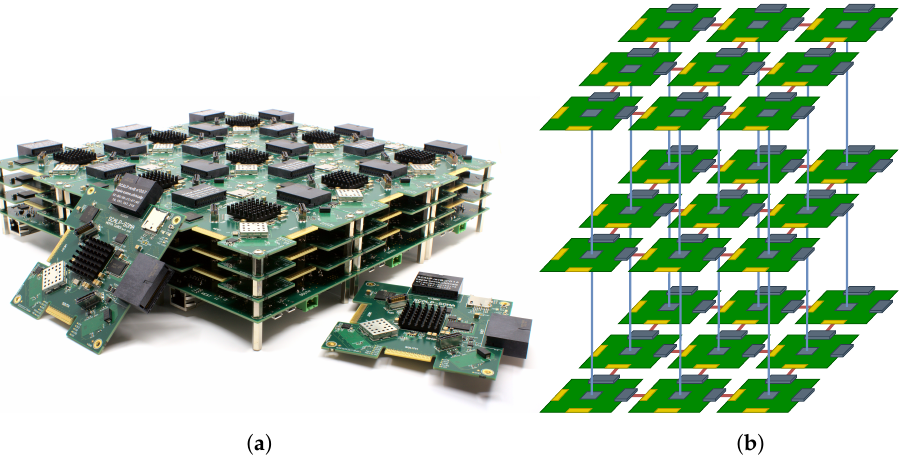
Figure 1. Illustration of SCALP board and its network topology. ( a ) Array of SCALP nodes. ( b ) SCALP array communications links. Red lines represent bi-directional high-speed connection. Blue lines show bi-directional differential